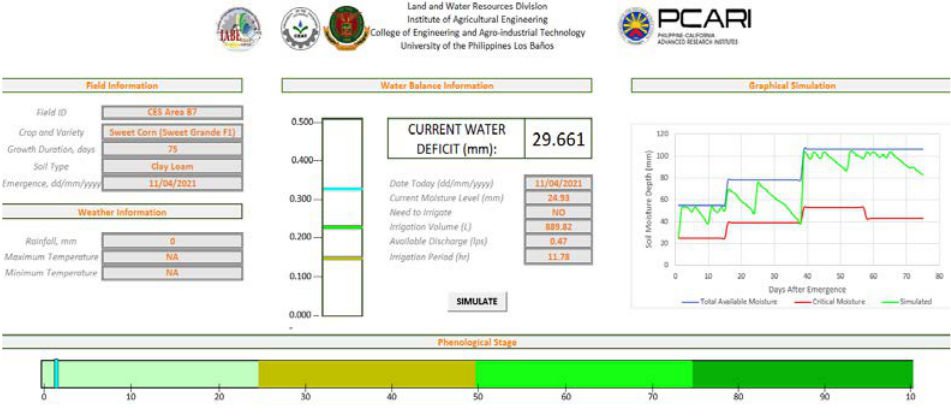
Figure 3. Graphical user interface of the program.